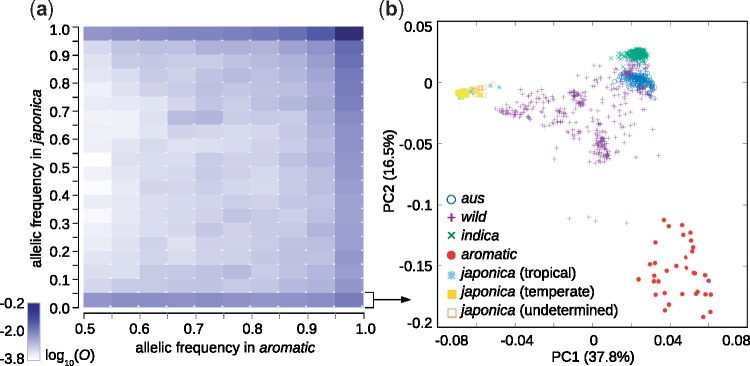
—Non-japonica variants present in the aromatic group. (a) Joint allele frequency spectrum summarizing frequency distribution of major aromatic alleles and their occurrence in japonica. Logarithmic transformation was used for the observed frequencies. The largest fraction of the examined sites is invariant in the two groups (the top-right field); however, 100,016 major aromatic alleles are rare or absent in japonica (the bottom row). (b) PCA constructed from the 100,016 sites identified above.